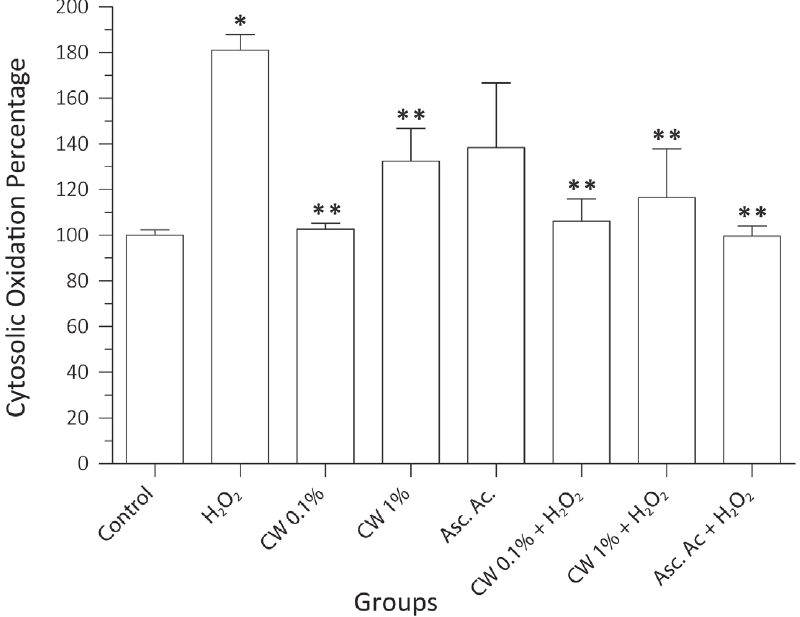
Figure 2 - Accumulation of intracellular ROS expressed in cytosolic oxidation percentage. The samples were pre-incubated with Coconut Water (CW) at 0.1 and 1 % of final concentration or Ascorbic Acid (Asc. Ac.) 25 µg/mL at the well plate, washed and exposed to the same equitoxic concentrations of H O (100 µM) for 5 minutes and measured after 20 2 2 minutes of DCFH-DA incubation. A negative control group using distilled water (Control) was performed.Data are means ± SD (n=3). (*) These data are significantly different when compared with the Control group (p<0.05). (**) These data are significantly different when compared with the H O group (p<0.05). For multiple comparisons, ANOVA, followed by 2 2 Tukey’s test, were